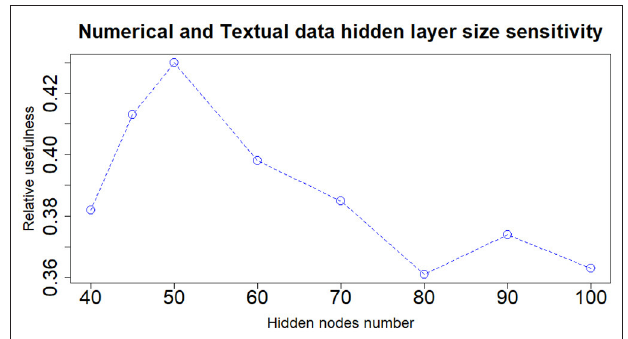
FIGURE 4 | Numerical and textual data—sensitivity analysis on the number of nodes of the hidden layer.